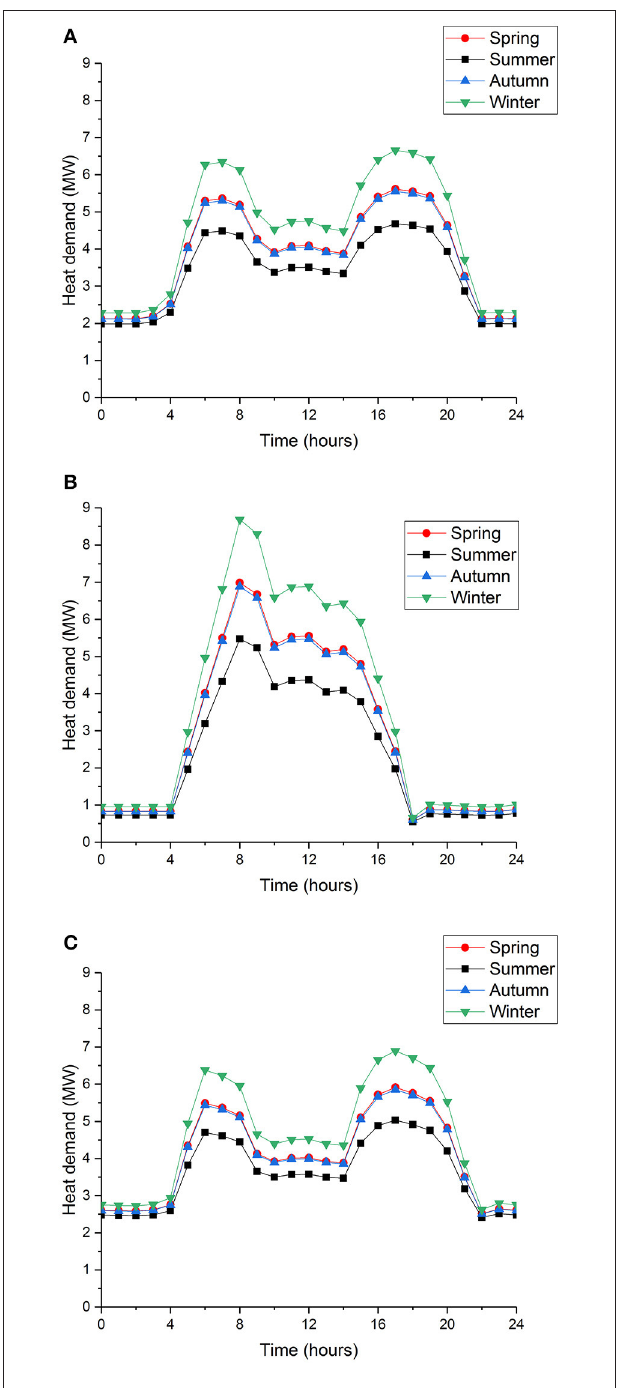
FIGURE 1 | (A) The hourly heat demand profiles generated using case study 1, Darley Dale, England, with a maximum allowable heat loss in the pipes